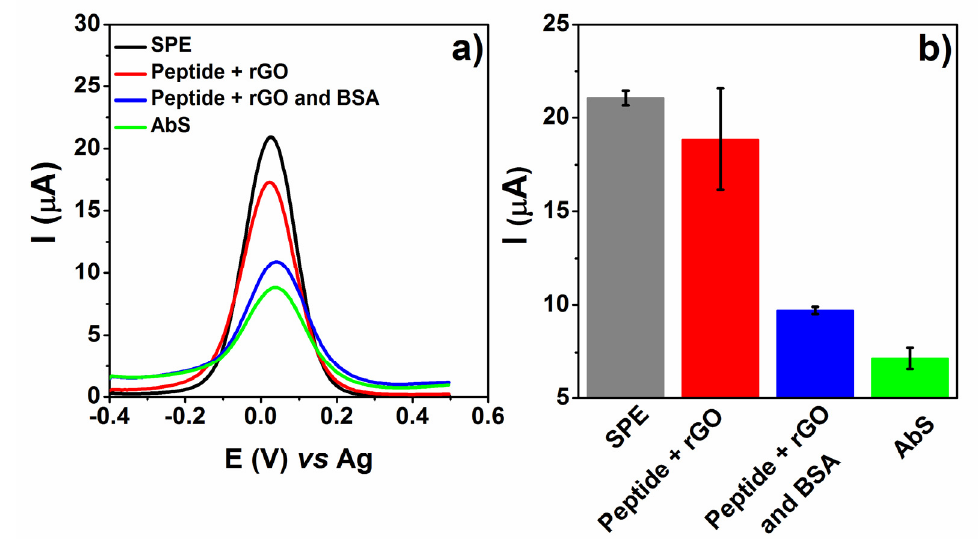
Figure 3. ( a ) DPVs obtained for each step of the immunosensor construction with peptide, rGO and BSA, with 1 mmol L − 1 K 3 [Fe(CN) 6 ] in PBS 0.1 mol L − 1 . ( b ) Summarized data obtained from probe current peak to each step of building up the sensor ( n = 3, ±SD).